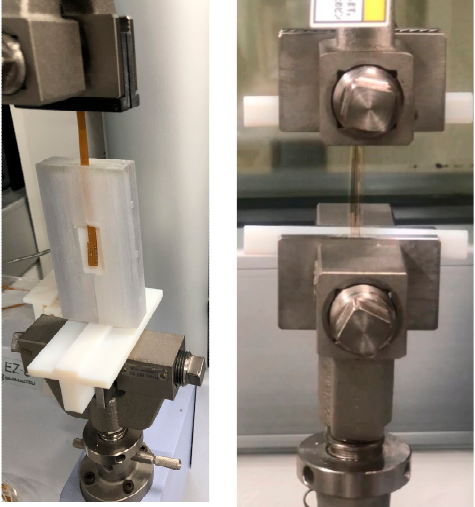
Figure 3. Tensile tests of the FPCB and PSPI test samples.